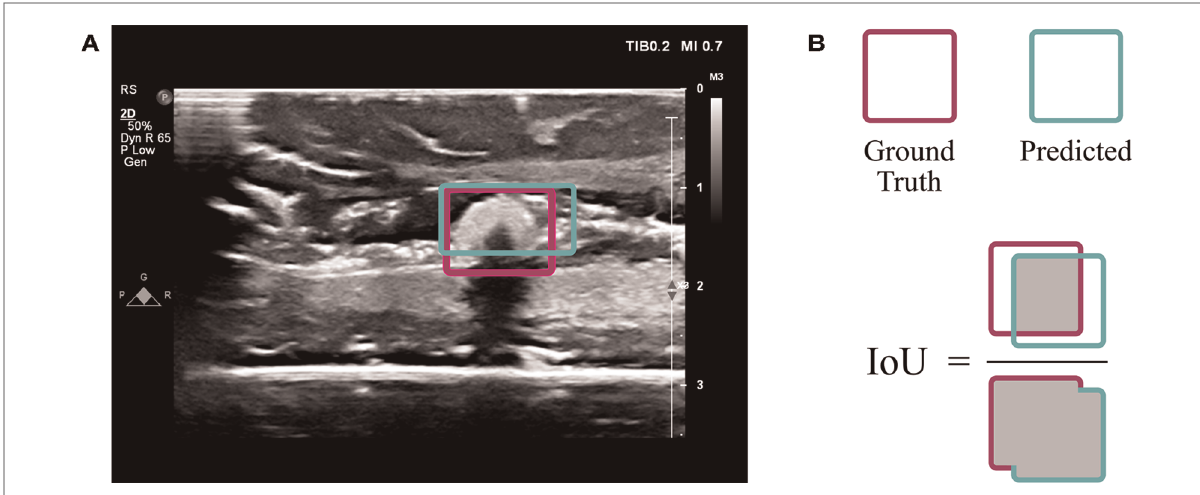
FIGURE 4 Evaluation using intersection over union (IoU). ( A ) An ultrasound image from the test set indicates the overlap of ground truth annotation of the cotton ball (magenta) with the predicted result by the CNN (sea green). ( B ) The extent of overlap is assessed by computing the area of overlap divided by area of union, known as the